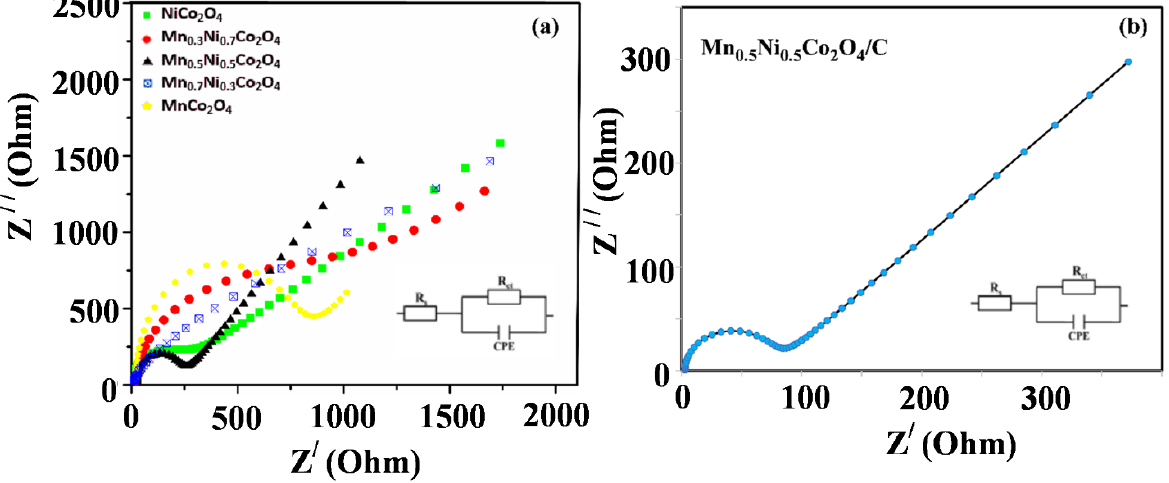
Figure 10. Nyquist plots of the ( a ) as-synthesized Mn x Ni 1 − x Co 2 O 4 spinel series and ( b ) Mn 0.5 Ni 0.5 Co 2 O 4 /C in O 2 -saturated 0.1 M KOH at 1.2 V vs. RHE.